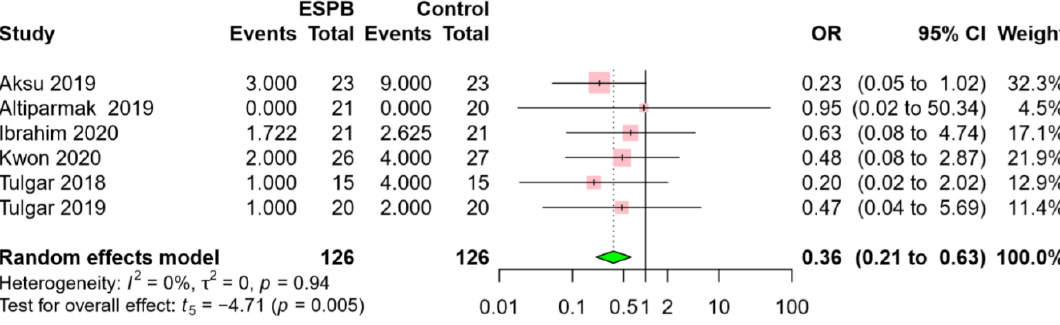
Figure 5. Forest plot for postoperative nausea and vomiting (PONV). ESPB reduced the incidence of PONV. Abbreviations: ESPB, erector spinae plane block; OR, odds ratio; CI, confidence interval.